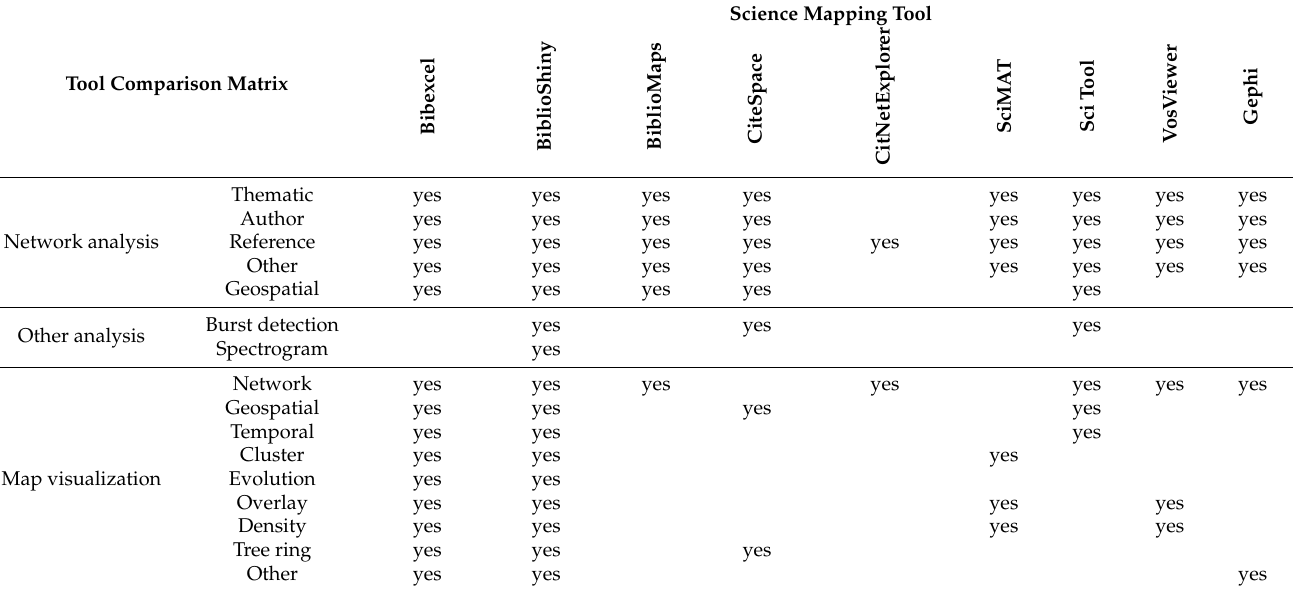
Table 1. Science mapping tool features (adapted from Moral-Muñoz et al. [48]).